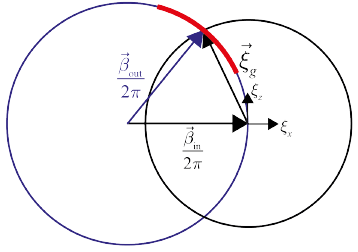
Figure A1. Schematic of a Fourier plane (red) in reciprocal space as it can be sampled by for instance an image detector that is placed at a Fourier plane of an optical system. The violet circle is the set of possible outgoing modes (cid:126) β out and the vector that is depicted fulfills the diffraction condition. The schematic is a slice of reciprocal space along the ξ x , ξ z direction and must be imagined in 3D. Furthermore, equal momentum of incoming and outgoing mode were assumed, which is only the case if they propagate in media with equal refractive